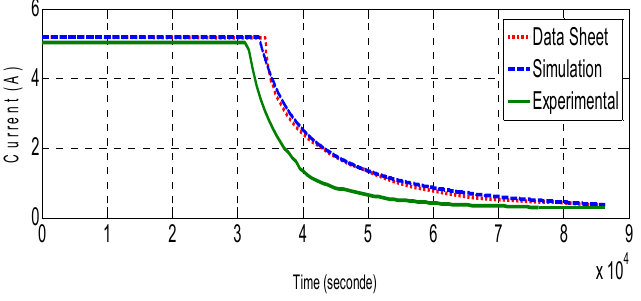
Figure 11. The charging current as the function of time.